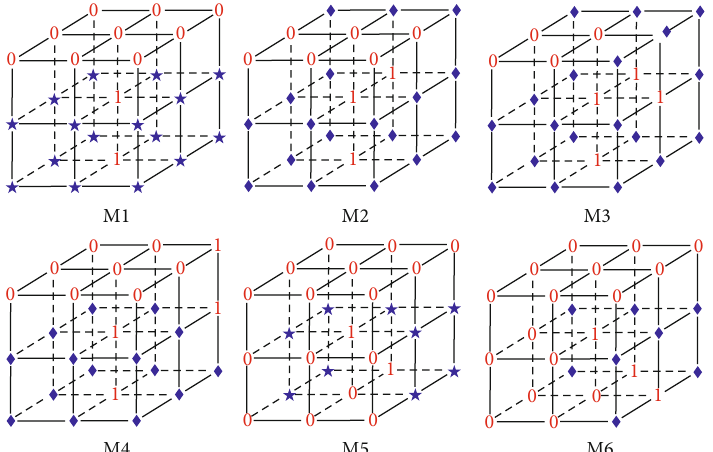
Figure 3: Deletion templates along the U direction. “ ★ , ” “ 1, ” “ 0, ” and “ ♦ ” represent the points that at least one of them is black, black point, white point, and the point either black or white, respectively